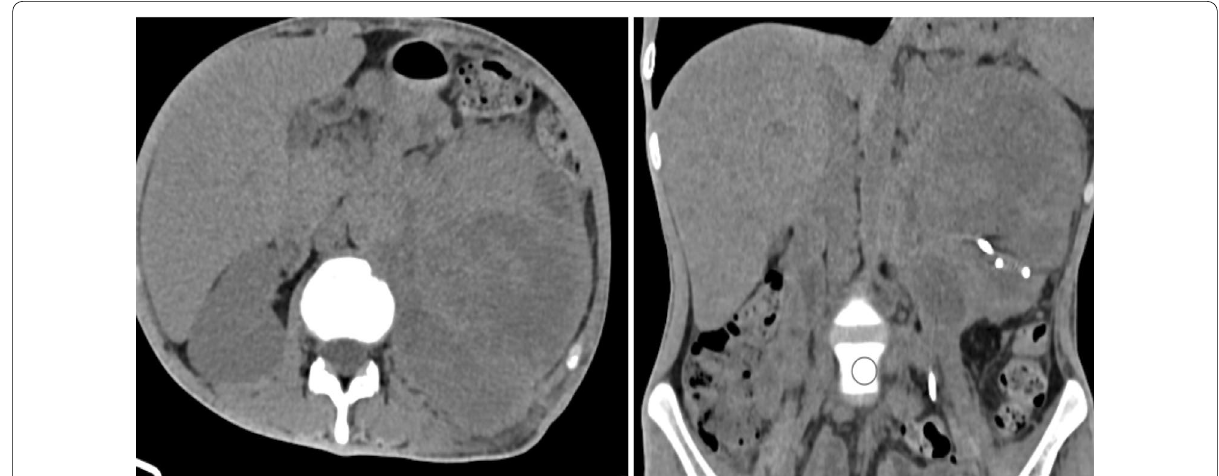
Fig. 2 Grossly enlarged left kidney with multiple pockets of collection at the left kidney demonstrating hydronephrosis suggesting pyonephrosis with left ureteral stent noted in